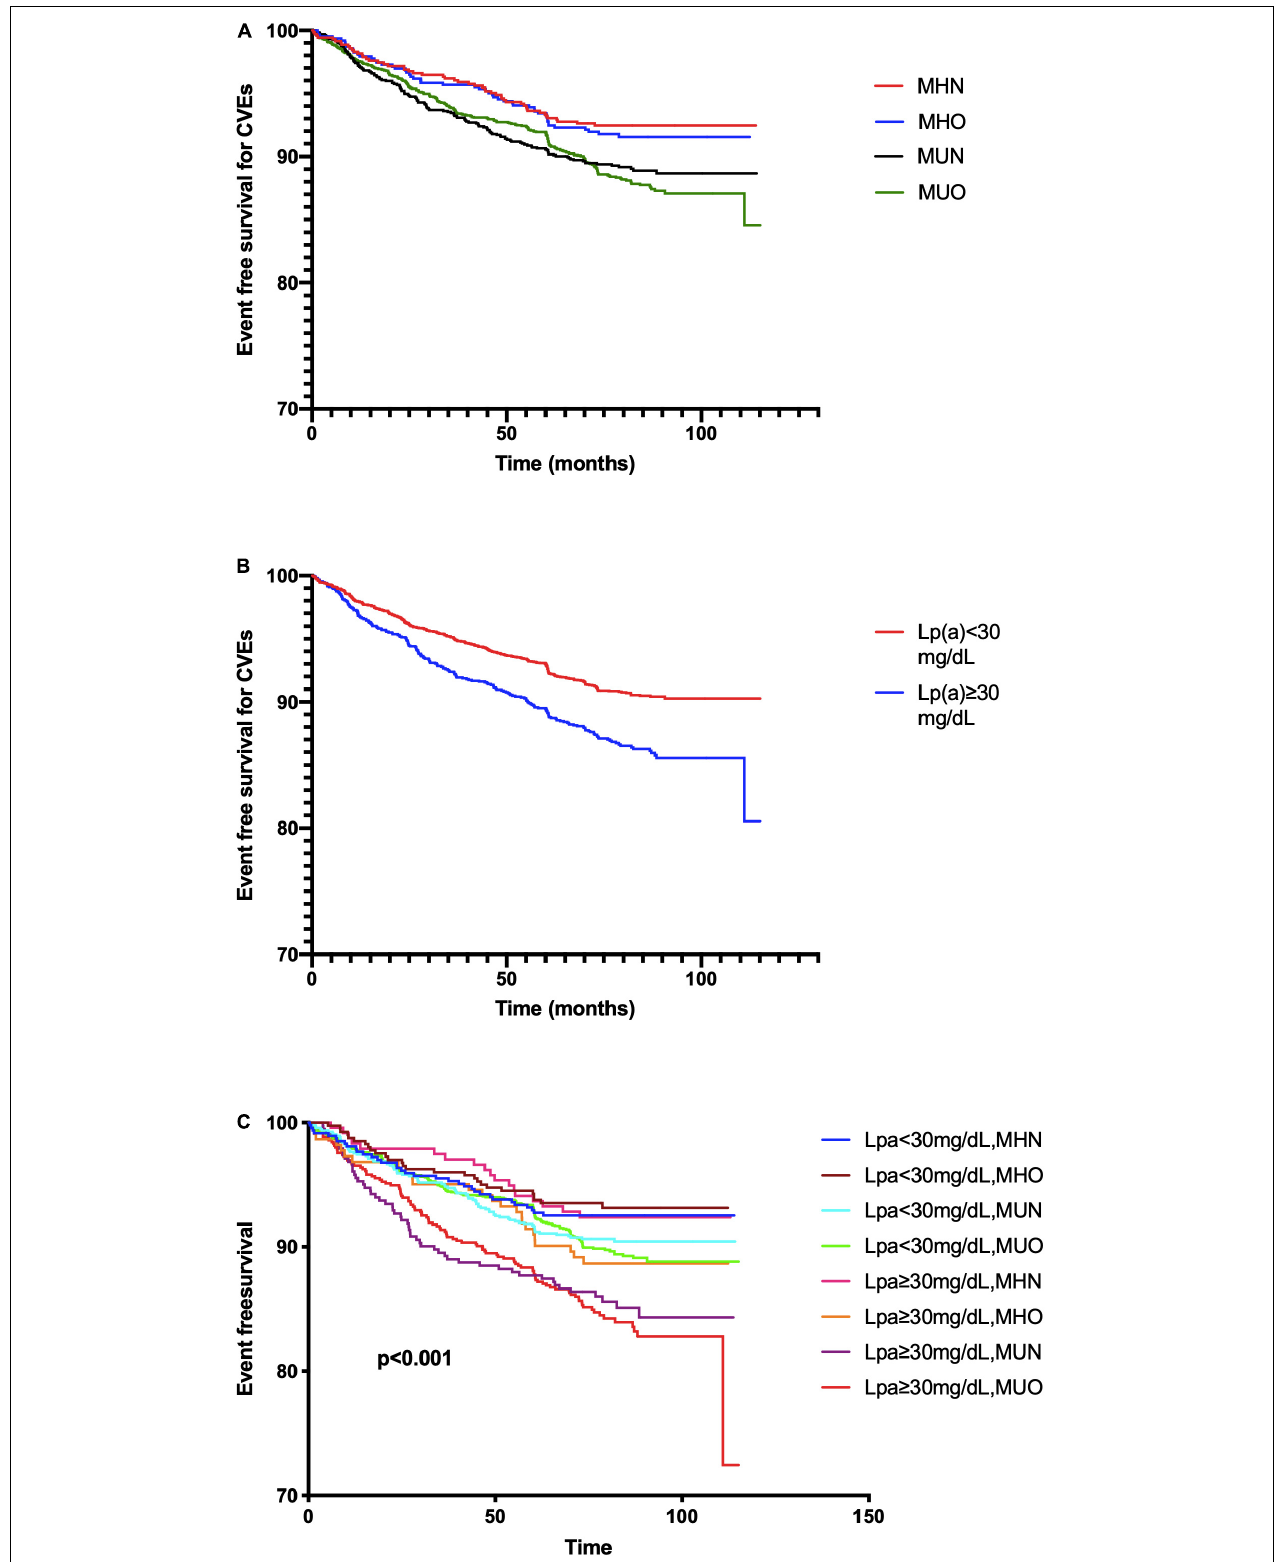
FIGURE 2 | The Kaplan–Meier analysis according to (A) metabolic phenotype; (B) Lp(a) levels; and (C) both status of metabolic phenotype and Lp(a).